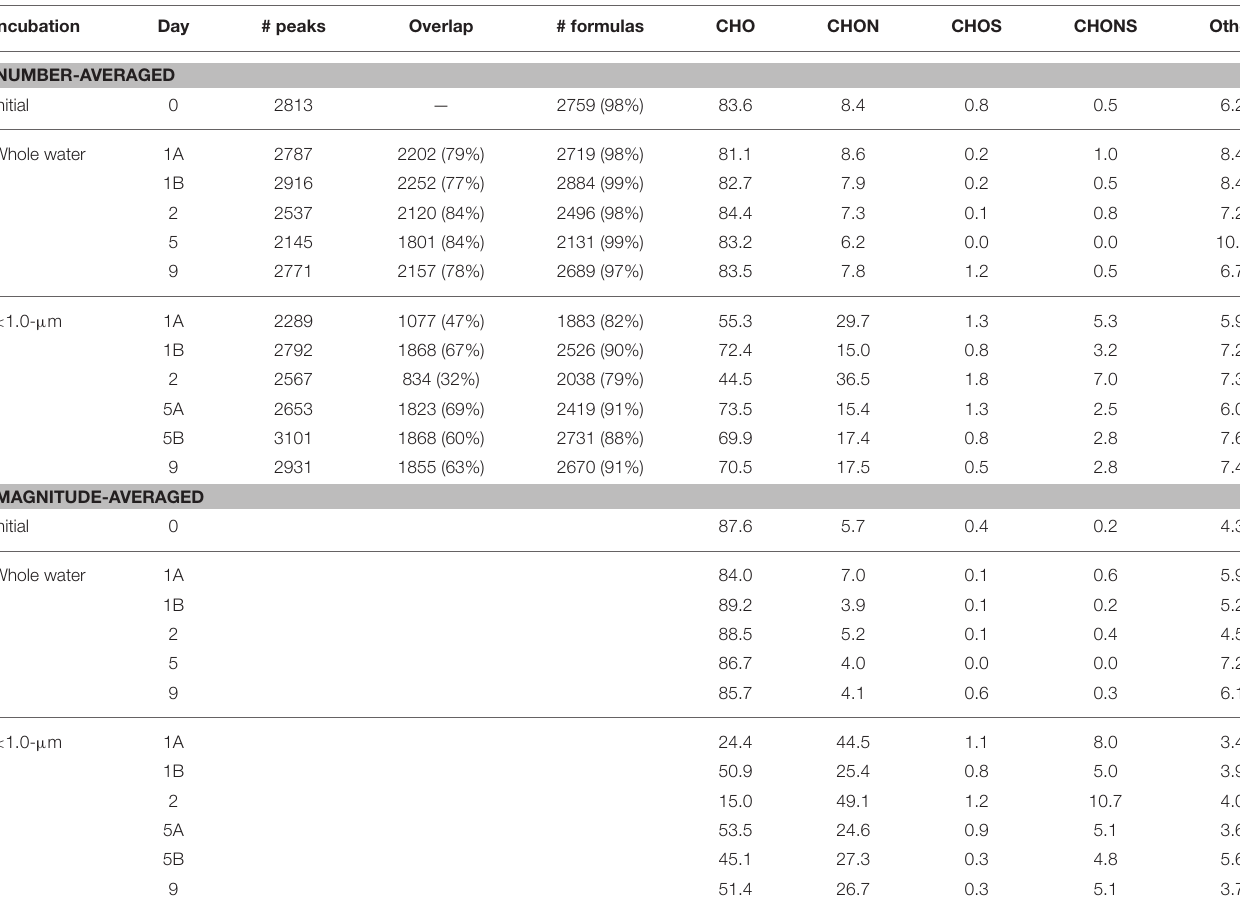
TABLE 2 | Formula classes for each mass